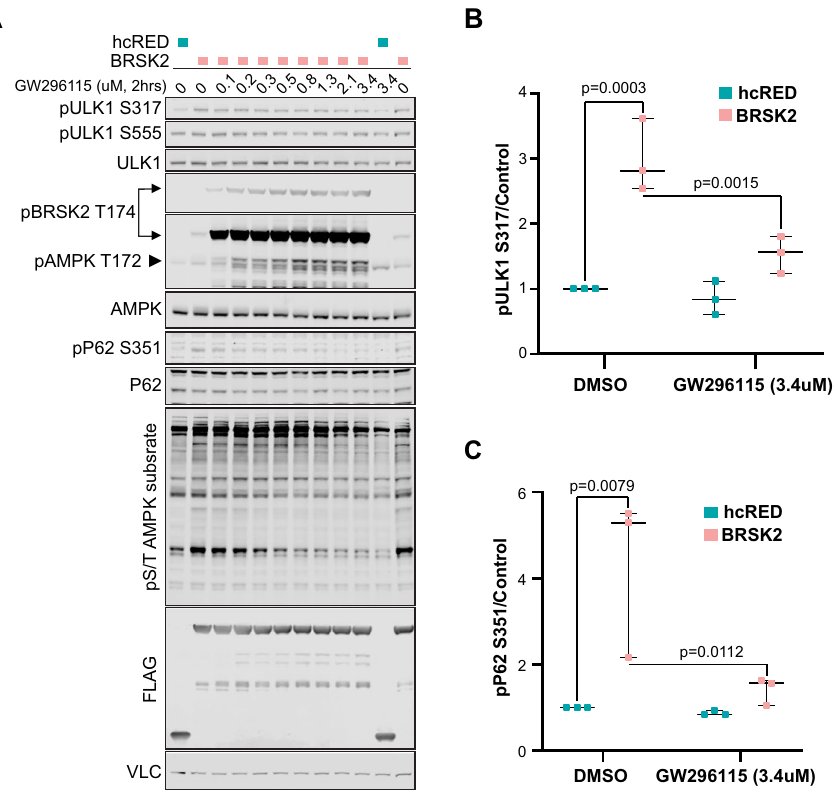
Figure 4. GW296115 dose-dependently inhibits BRSK2-induced phosphorylation. ( A ) BRSK2 overexpression induced pULK1 S317, pP62 S351, and pS/T AMPK substrates are decreased dose-dependently by GW296115. HEK293T cells were transiently transfected with hcRED or BRSK2 for 24 h before GW296115 treatment for 2 h. Unformatted images of blots are included in Fig. S2. ( B , C ) Western blot quantitation for pULK1 s317 and pP62 S351 treated with DMSO or GW296115 at 3.4 μM shows statistically significant changes (N =